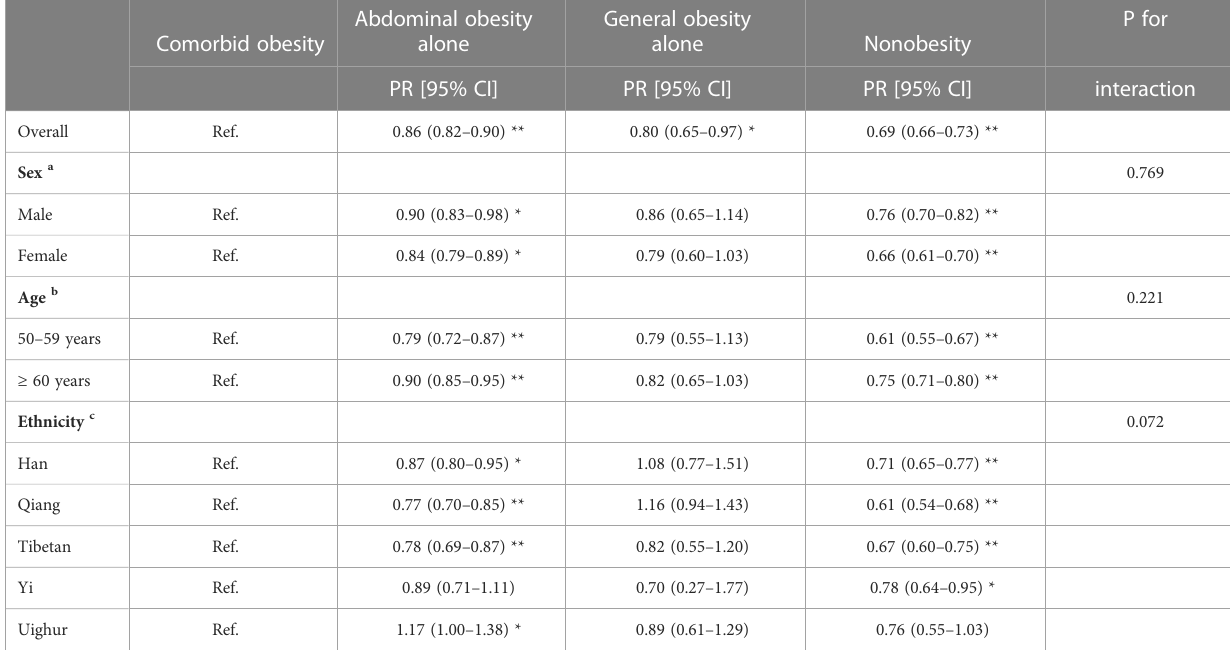
TABLE 4 Associations of obesity subgroups with hypertension in the adjusted